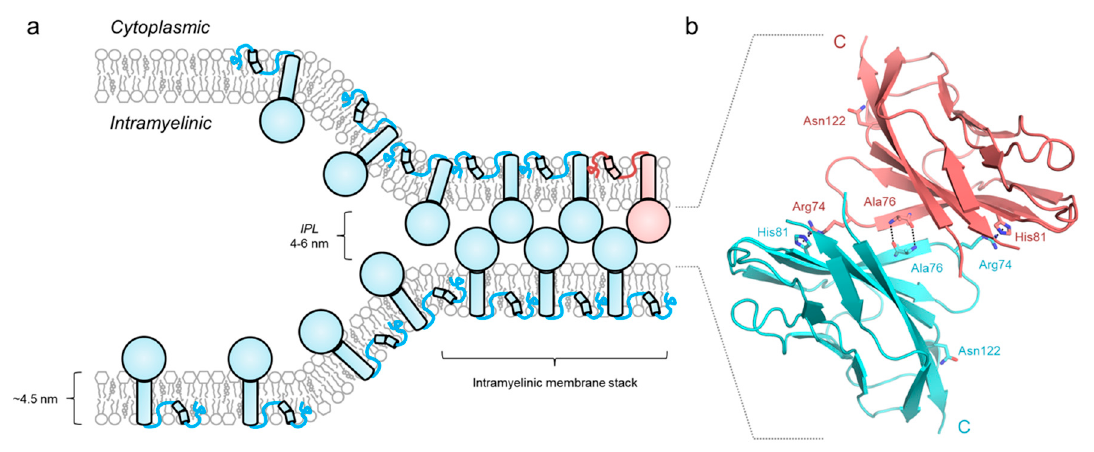
Figure 2. The arrangement of P0 in the IPL. ( a ) Homophilic intercalation of P0 Ig-like domains forms the basis of membrane stack stability in the PNS intramyelinic compartment. ( b ) Structural basis of the homophilic interaction between two apposing Ig-like domains. The intermolecular interaction occurs between the β 4 strand backbone atoms of each Ig-like domain and between Arg74 and His81, and is based on the crystal packing of rat P0 (PDB ID 1NEU [37]). The dashed lines (black) represent hydrogen bonds between the backbone atoms of Ala76 and the ion-dipole interactions between Arg78 and His81 sidechains of each Ig-like domain. The conserved Asn122 glycosylation site is shown.